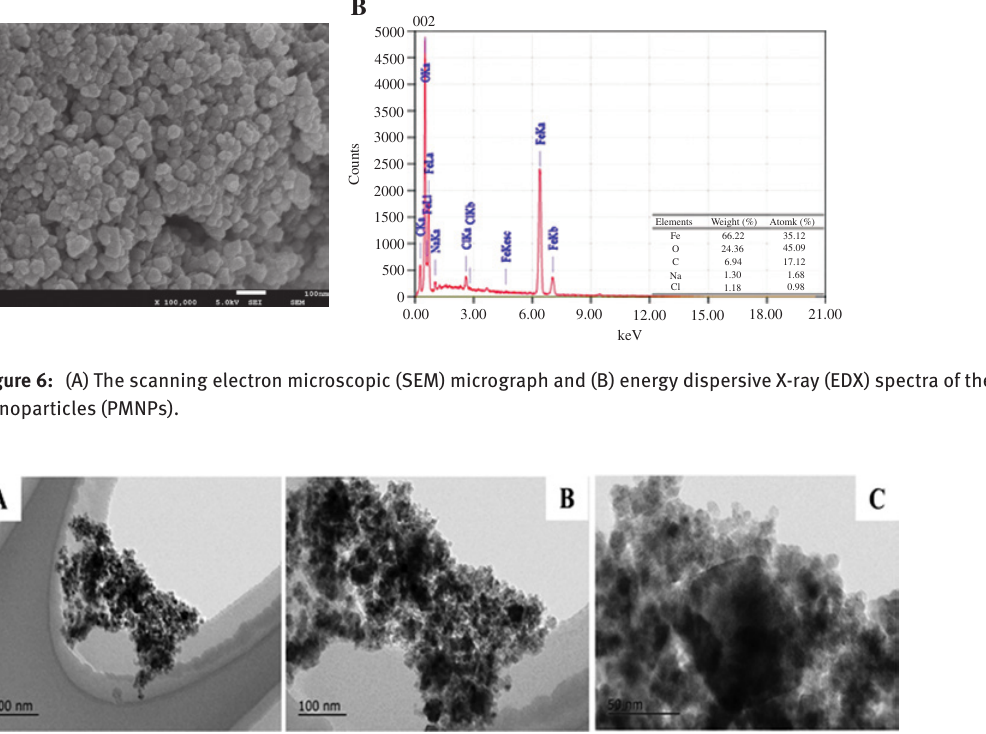
Figure 7: The transmission electron microscopy (TEM) images of the phytogenic magnetic nanoparticles (PMNPs); (A) 200 nm scale bar; (B) 100 nm scale bar; and (C) 50 nm scale